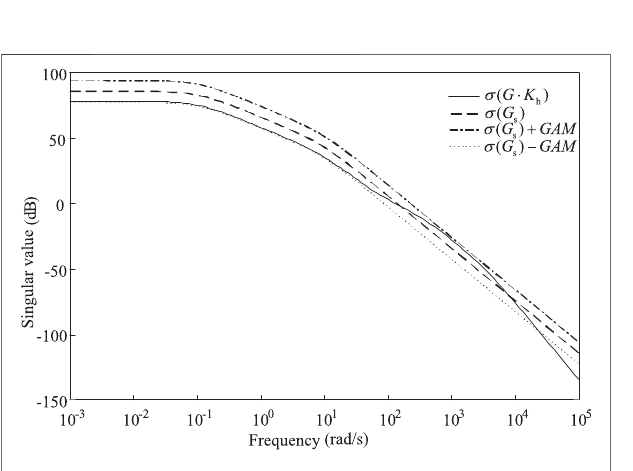
FIGURE 7 | The closed-loop singular value curves of the system before and after the addition of the robust controller.